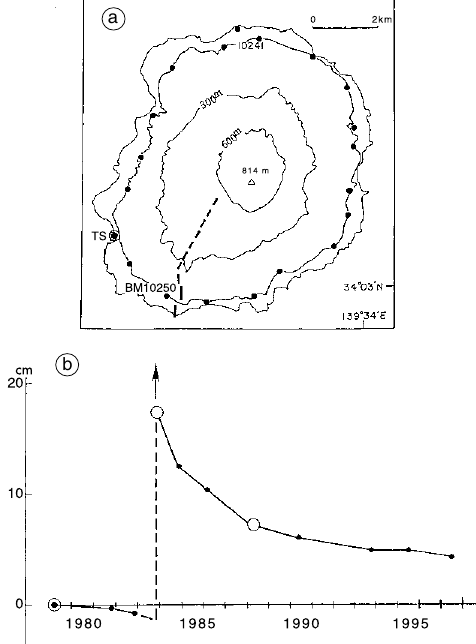
Fig. 11a,b. Miyakejima. a) Distribution of the benchmarks for the precise levels along the shore. A broken line indicates the line of the 1983 fissure eruption; b) Vertical deformation (cm) of a benchmark near the explosion site (BM 10250) referred to the tide gauge station (TS). The arrow indicates the eruption and the hollow circles interpolated values (after Yokoyama, 1996).